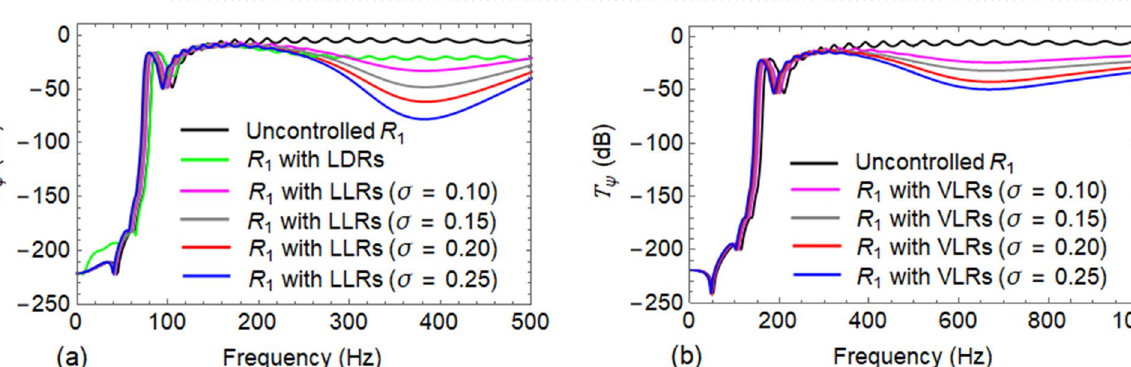
Figure 8. Effect of different damping values on the transmittance T ψ ( dB ) of R 1 when attached with LLRs and VLRs, respectively: ( a ) propagation of Wave #A; and ( b ) propagation of Wave #B.